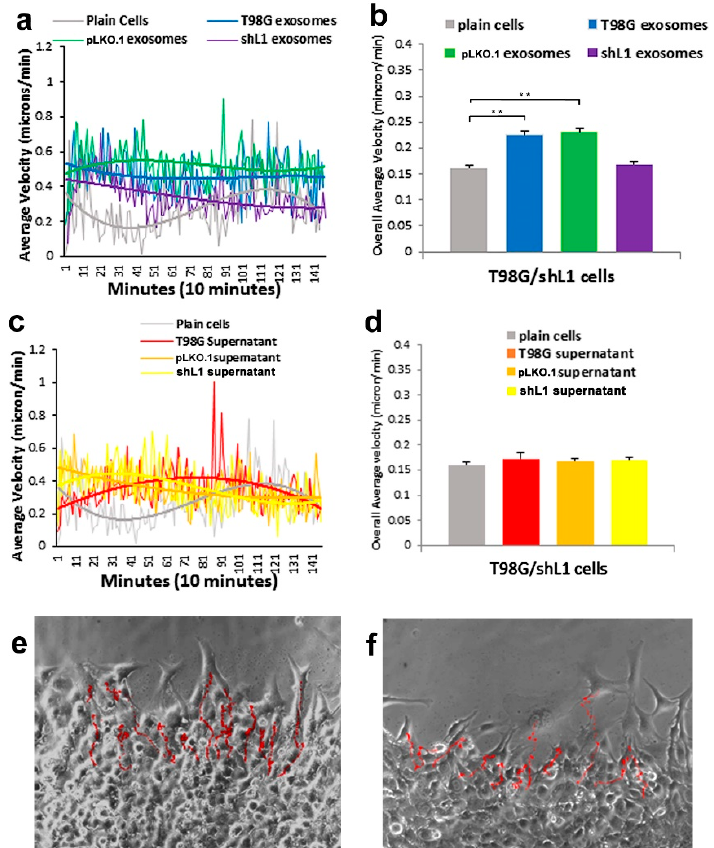
Figure 3. Motility of L1-attenuated T98G / shL1 cells after exosome and supernatant fraction treatment. ( a ) Average velocity of cells tracked over time with exosome fractions added. The trend lines (thick lines) for T98G and pLKO.1 exosome types were distinctly above those of the plain cells and shL1 exosomes. ( b ) Overall average velocity of cells with exosome treatments. ( c ) Average velocity of cells tracked over time with supernatant fractions added. ( d ) Overall average velocity of cells with supernatant treatments. There was no significance di ff erence in these motility rates with ANOVA analysis. ( e , f ) Cell track images of cells with T98G exosomes and T98G supernatant fractions, respectively. ** p < 0.001.